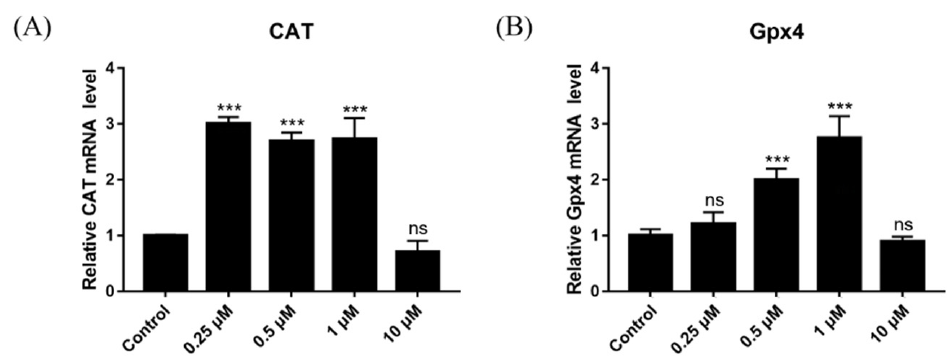
Figure 13. Effects of different concentrations of DSF on the relative mRNA expression of antioxidant- related genes. ( A ) relative expression of CAT mRNA in different groups; ( B ) relative expression of Gpx4 mRNA in different groups. *** p < 0.001, ns p > 0.05.